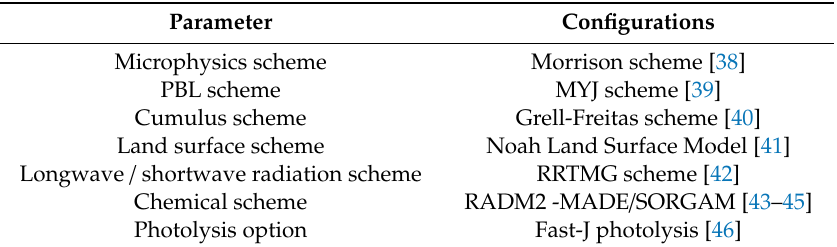
Figure 4. The two nested domains and spatial distribution of PM 2.5 emissions (shading; unit: μ g·m − 2 ·s − 1 ). The area enclosed by the dotted line is the DS region. Table 1. Physical parameterization schemes used in the simulations. Table 1. Physical parameterization schemes used in the simulations.